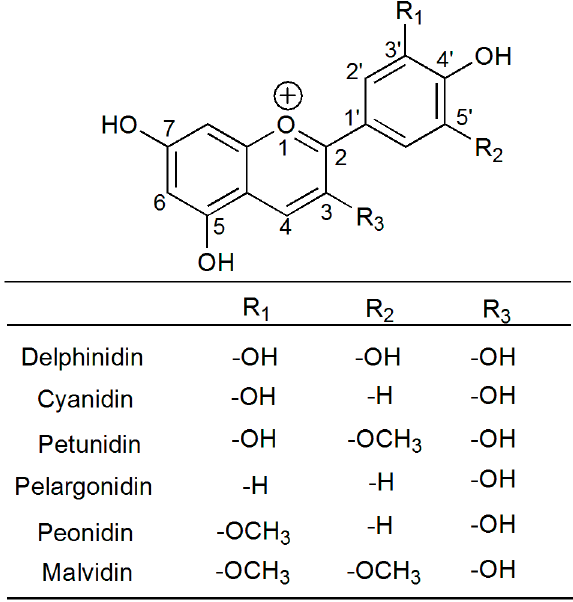
Figure 1. Structure of anthocyanidins.